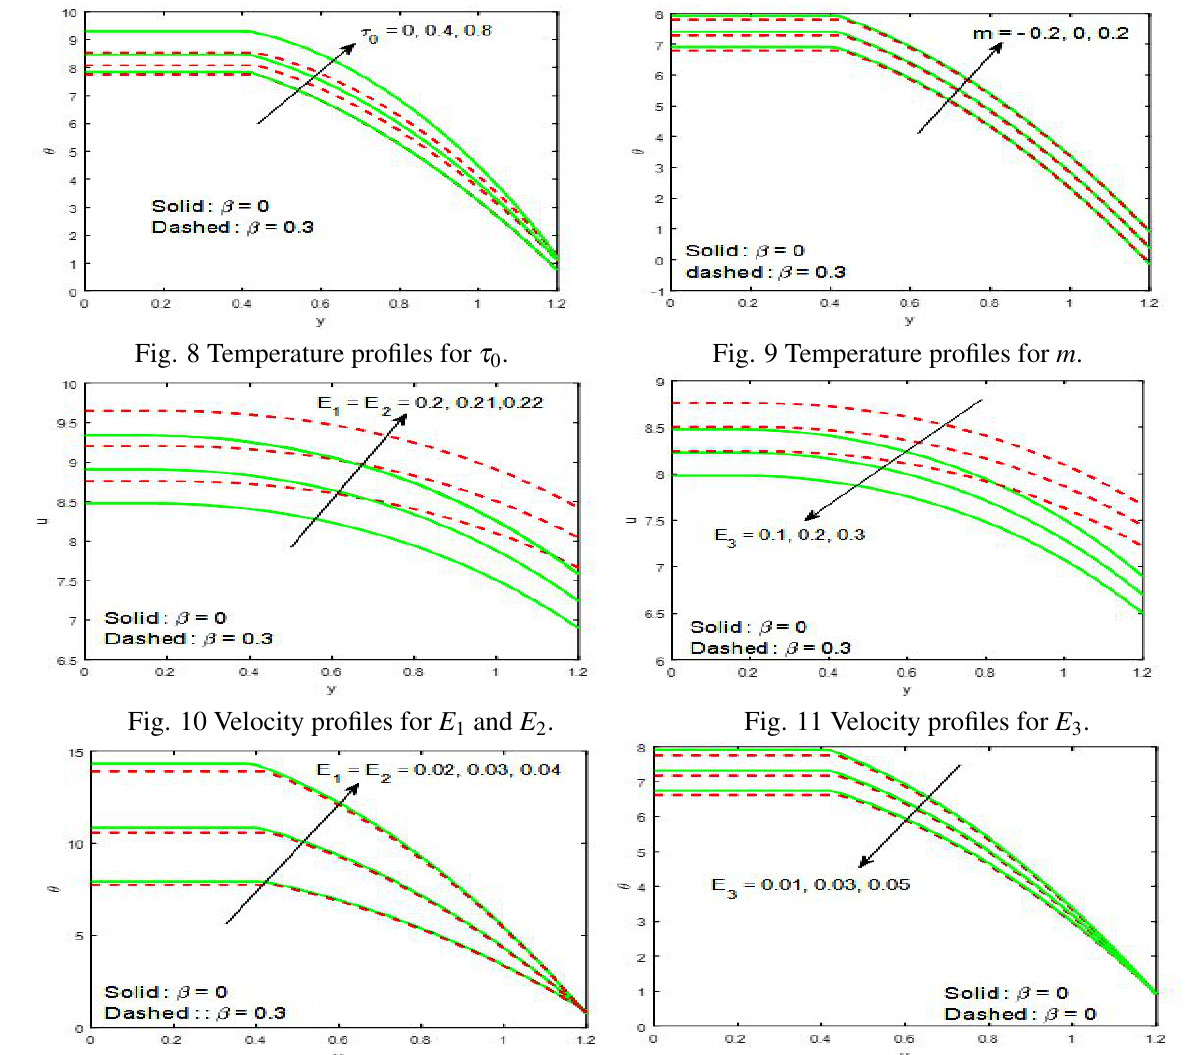
Fig. 12 Temperature profiles for E 1 and E 2 . Fig. 13 Temperature profiles for E 3